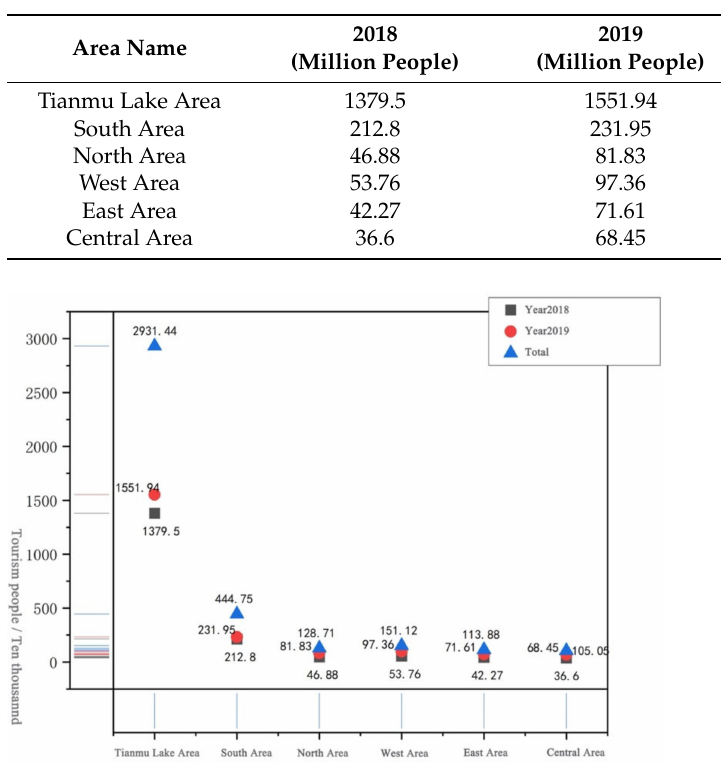
Table 6. List of in-year tourism numbers by region in Liyang, 2018–2019.